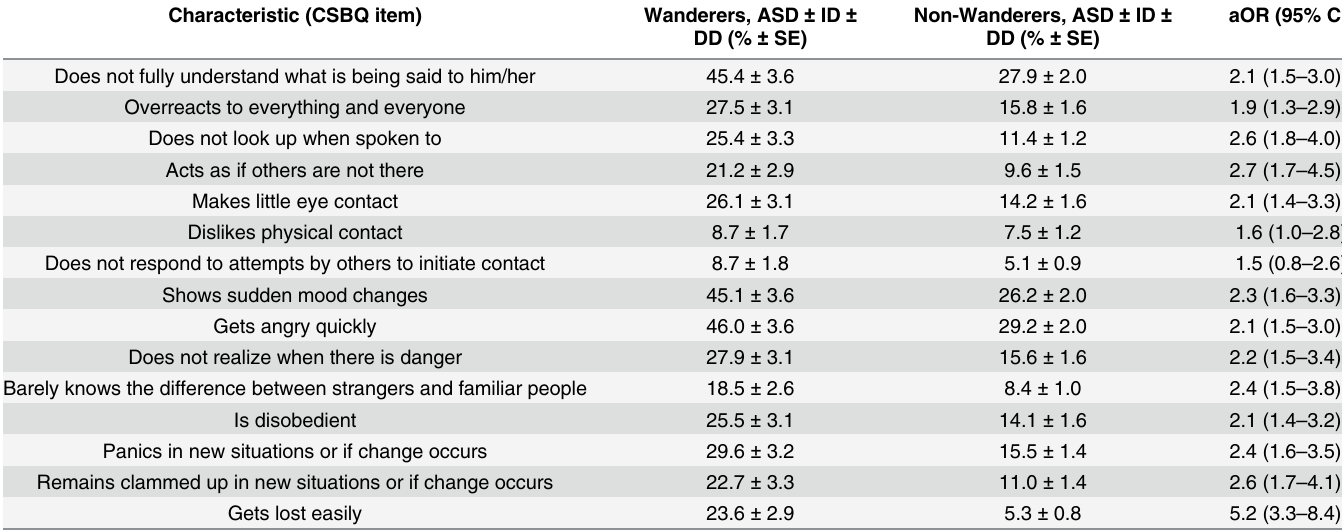
Table 6. Comparison of the Behavioral Characteristics of Wanderers and